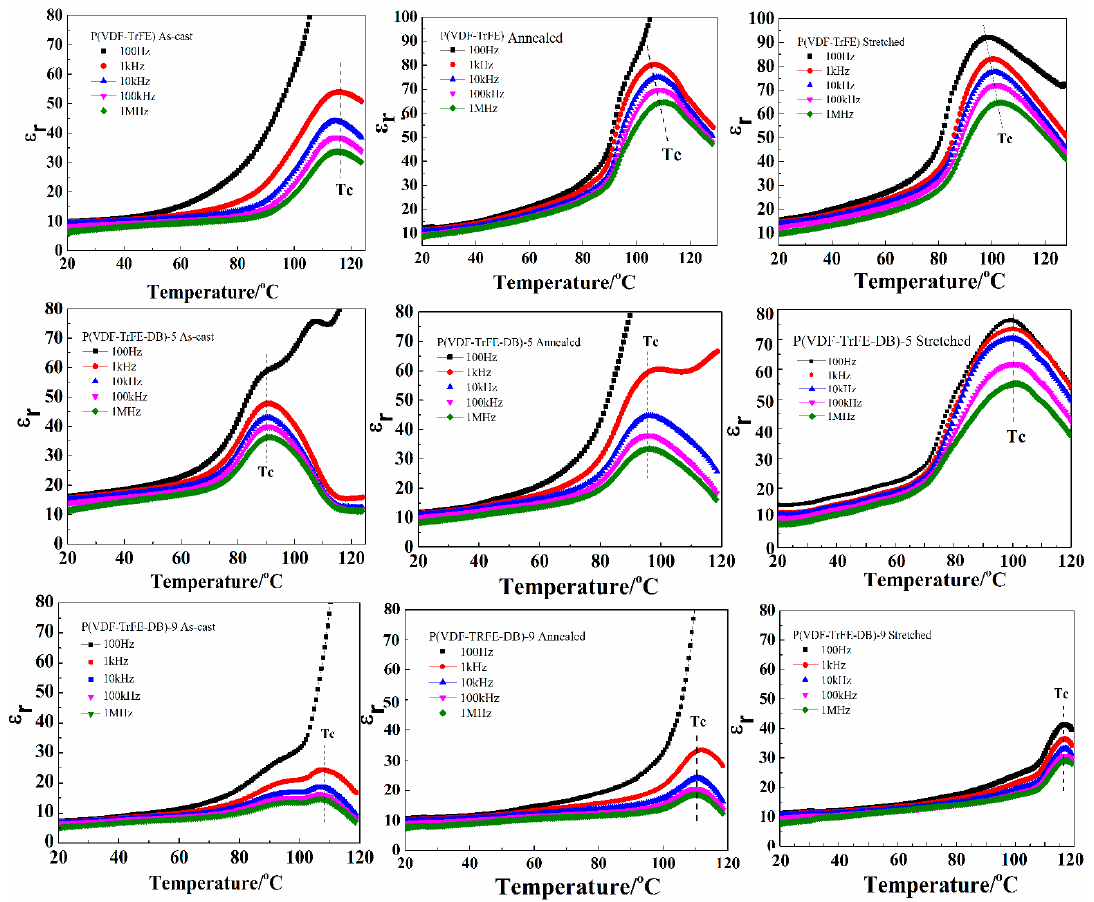
Figure 7. Influence of annealed and stretched treatment on the permittivity of P(VDF-TrFE), P(VDF-TrFE-DB)-5, and P(VDF-TrFE-DB)-9.